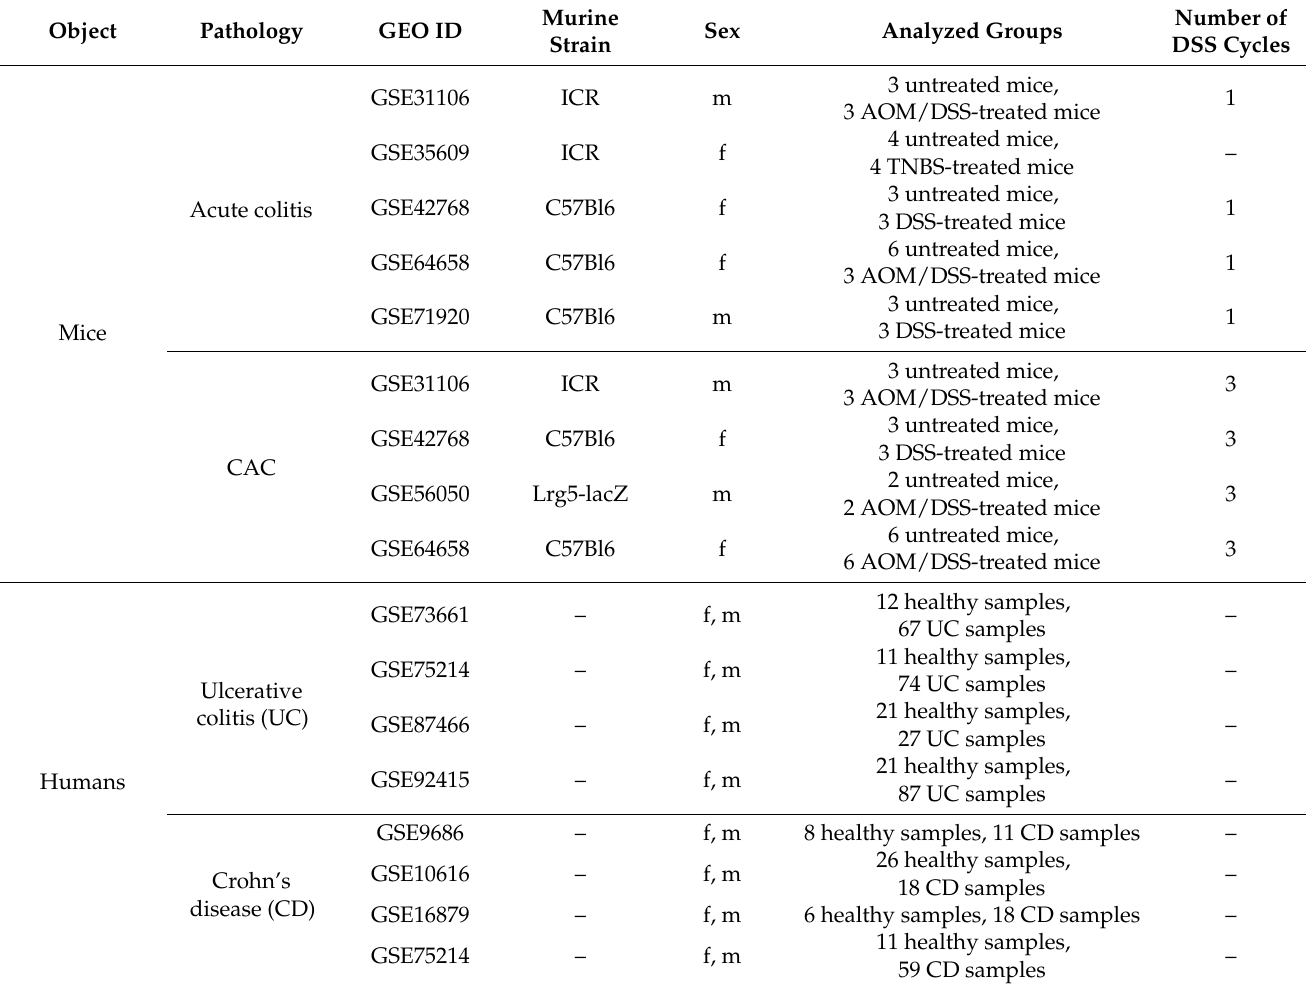
Table 1. The GEO microarray datasets used in the